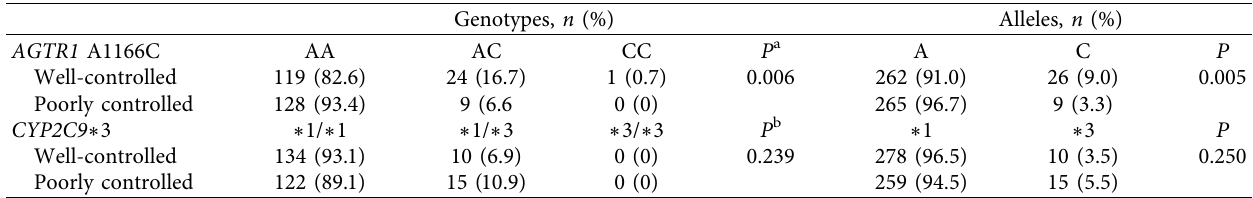
Table 2: Genotype distribution and allele frequency of AGTR1 A1166C and CYP2C9 ∗ 3 in well-controlled group ( n � 144) and poorly controlled group ( n �